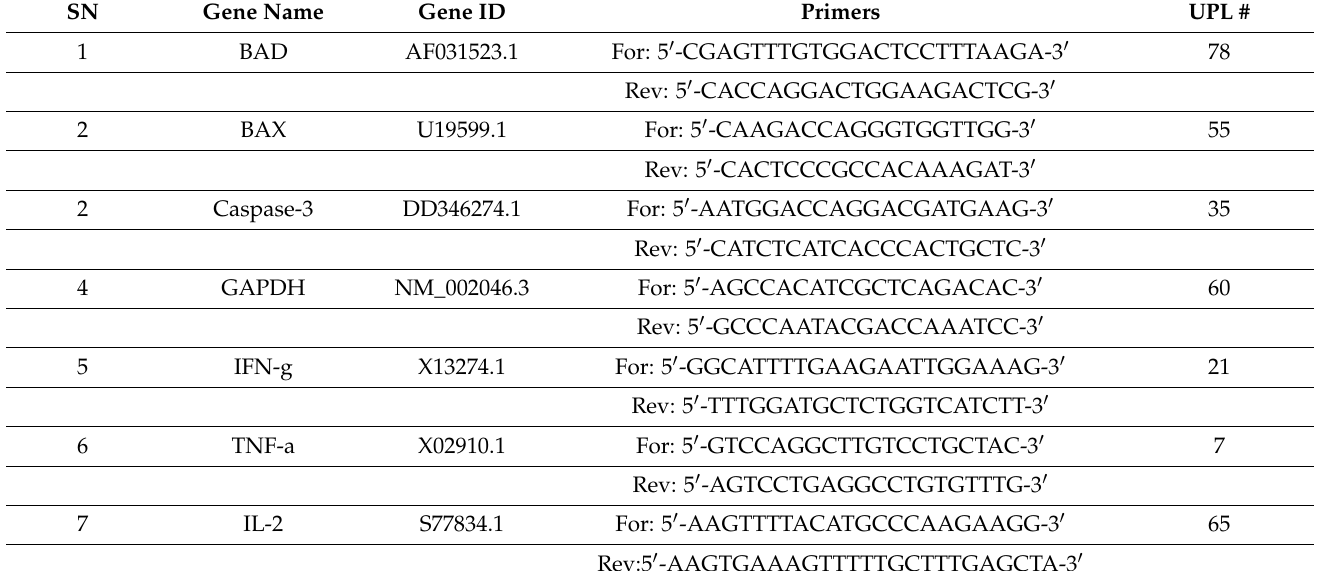
Table 2. List of human primers for